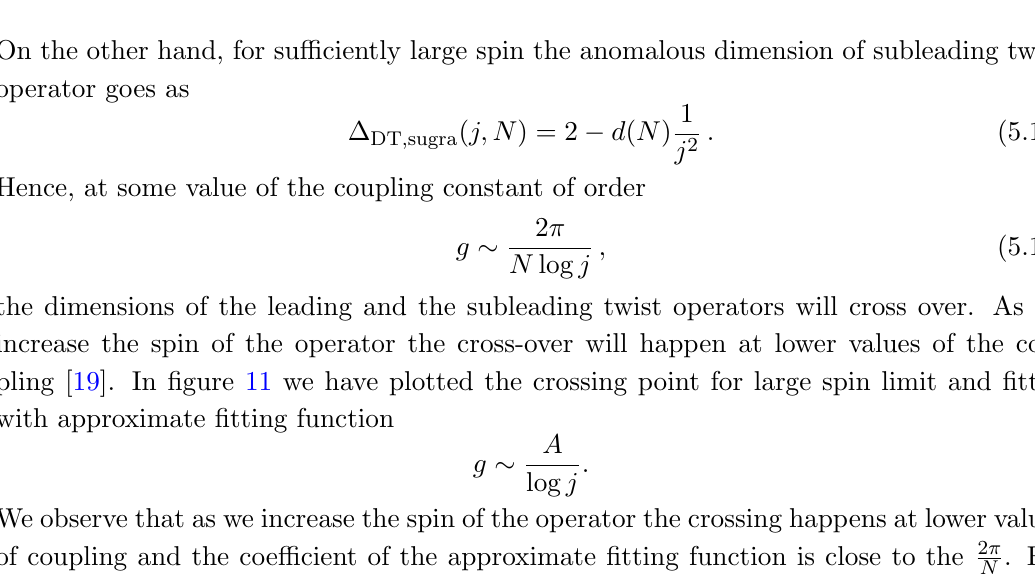
Figure 11. Crossing point for the dimensions of leading and subleading twist operators at (cid:12)nite values of N = 5 and N = 3 as a function of j . The crossing point is given by the intersection of the (Pad(cid:19)e for (cid:12)nite spin twist-two) and the (Pad(cid:18)e for twist-four). The solid curve is for the approximate (cid:12)tting function A for A = 1 : 18 ( N = 5) and A = 2 ( N = log j